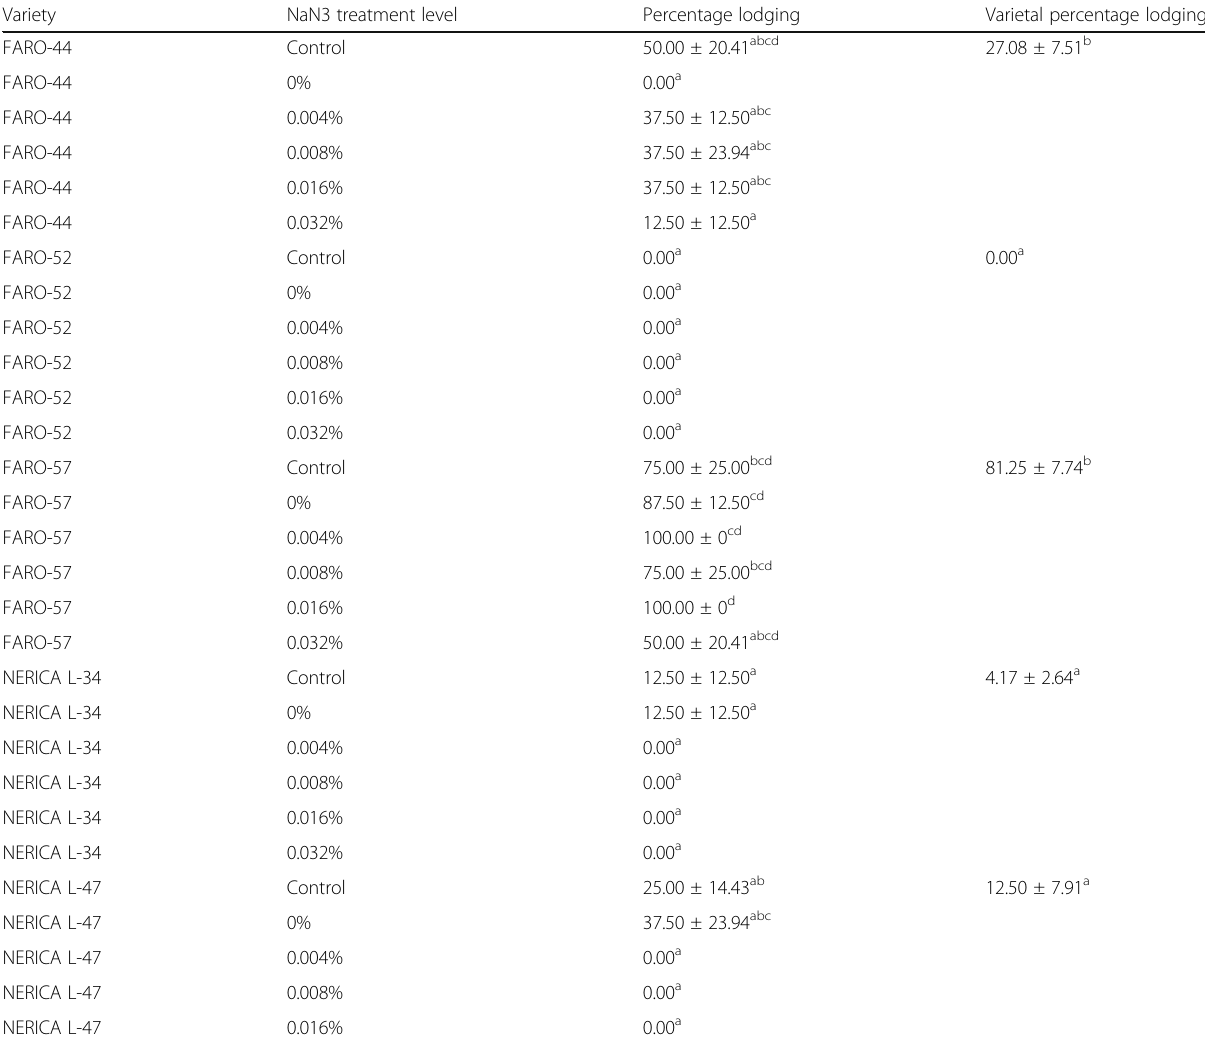
Table 6 Percentage lodging of the five rice varieties